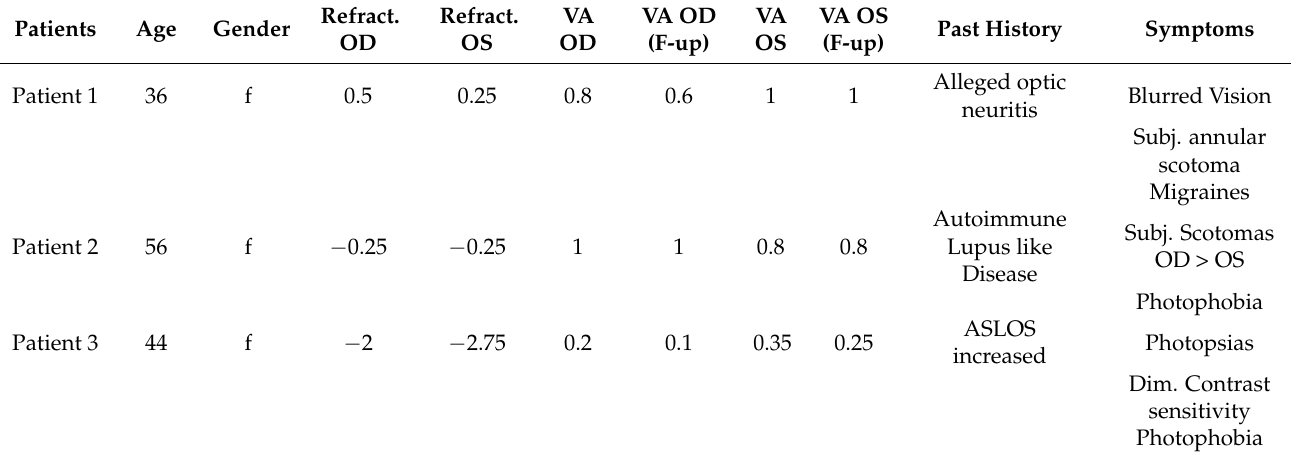
Table 1. Demographics, visual acuity, history and